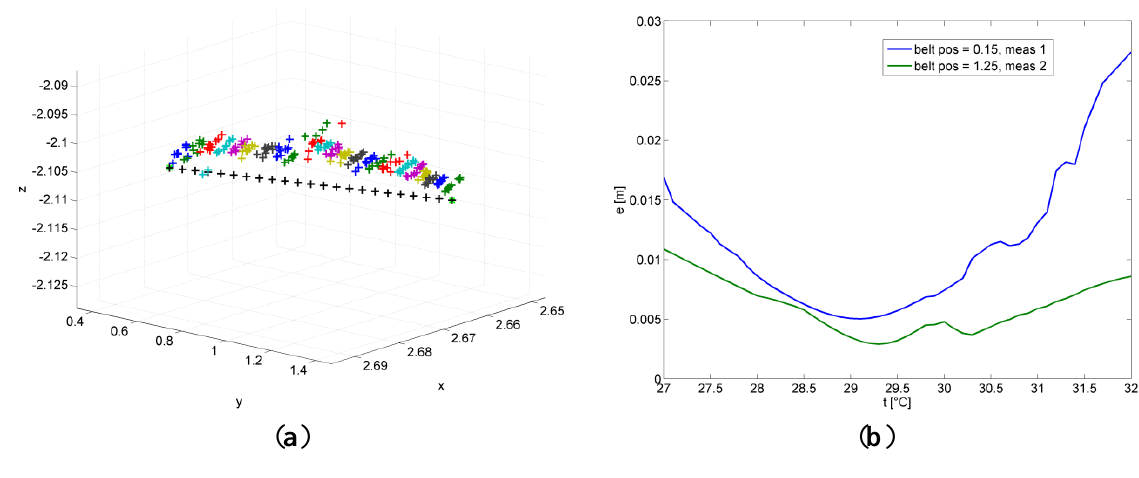
Figure 20. ( a ) Repeated measurement at different date and temperature; ( b ) Temperature obtained by using reference position was 29.1